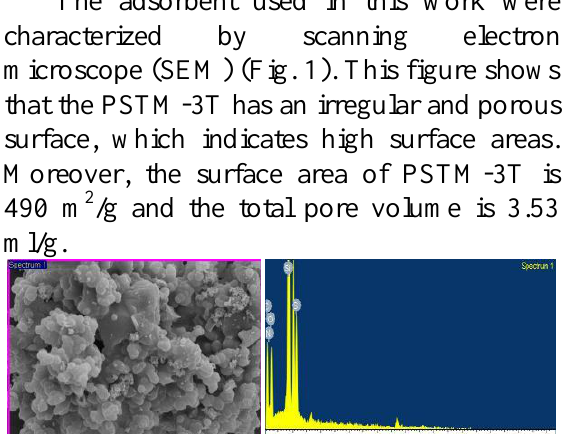
Fig. 1. SEM/EDS image of PSTM-3T Energy dispersive spectrometer (EDS)